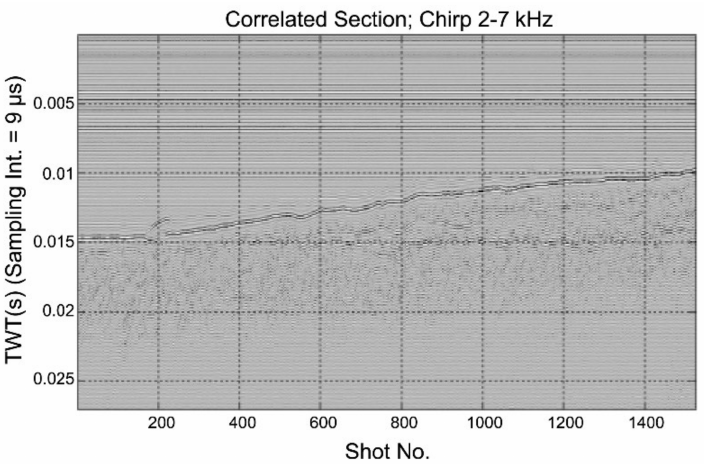
Figure 5. Chirp sub-bottom profiler (SBP) section after correlating raw data with the source signal shown in Figure 2. TWT = two-way travel